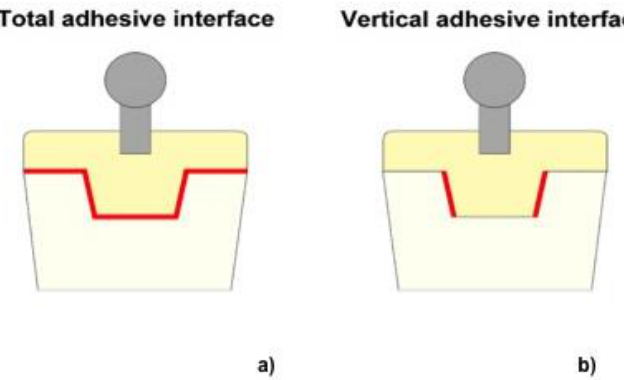
Figure 3. Schematic of definition of ( a ) total and ( b ) vertical adhesive interface considered during adhesive area calculation.